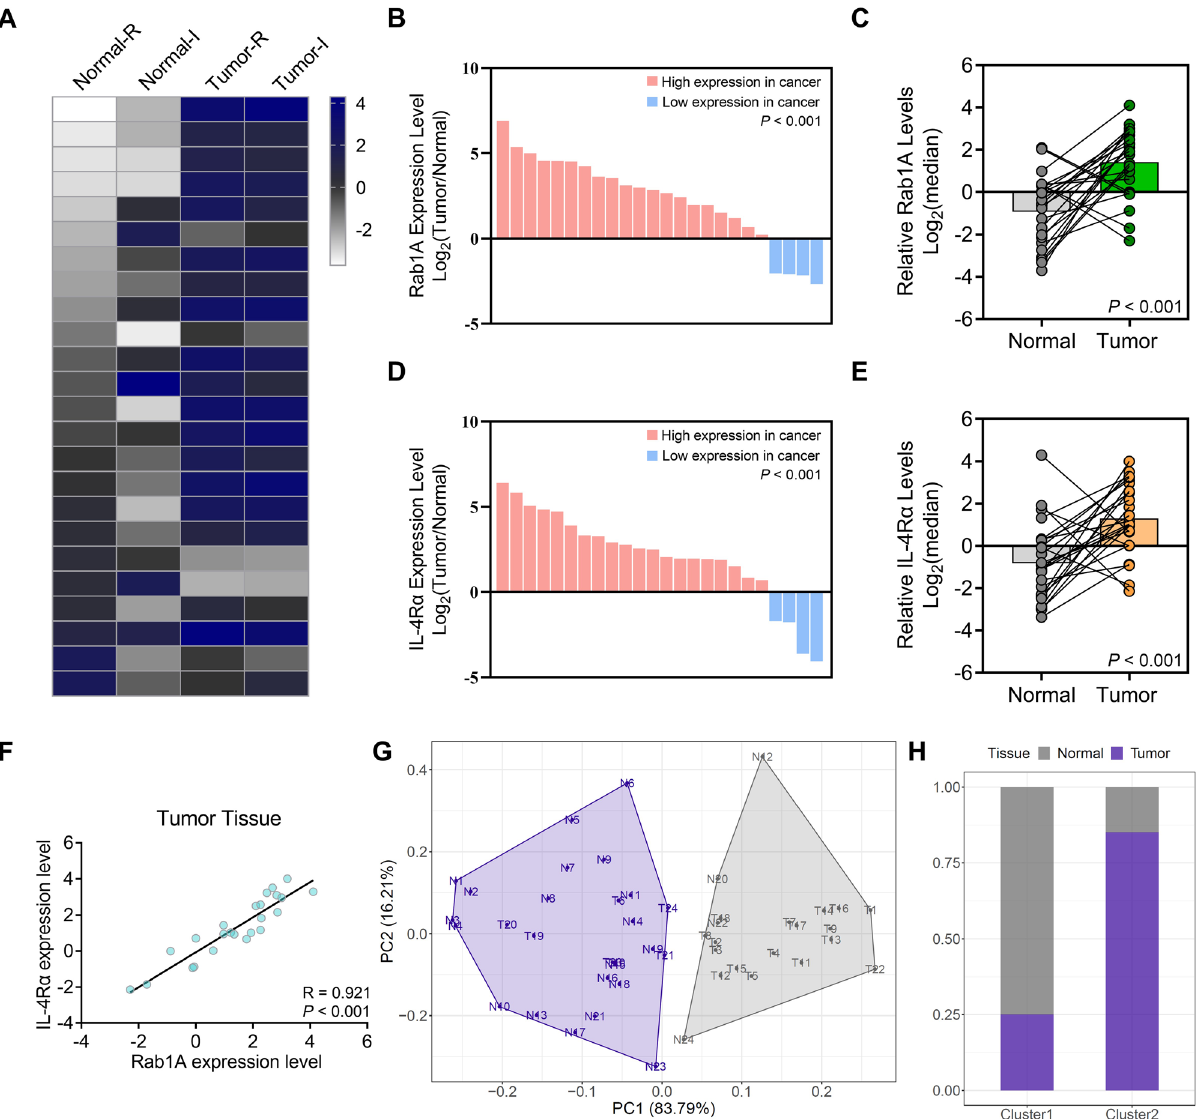
normal tissues. ( B , C ) Rab1A expression in GC and para-cancer tissues. ( D , E ) IL-4Rα expression in GC and para-cancer tissues. ( F ) The correlation between Rab1A and IL-4Rα expression in 20 GC tissues. ( G )